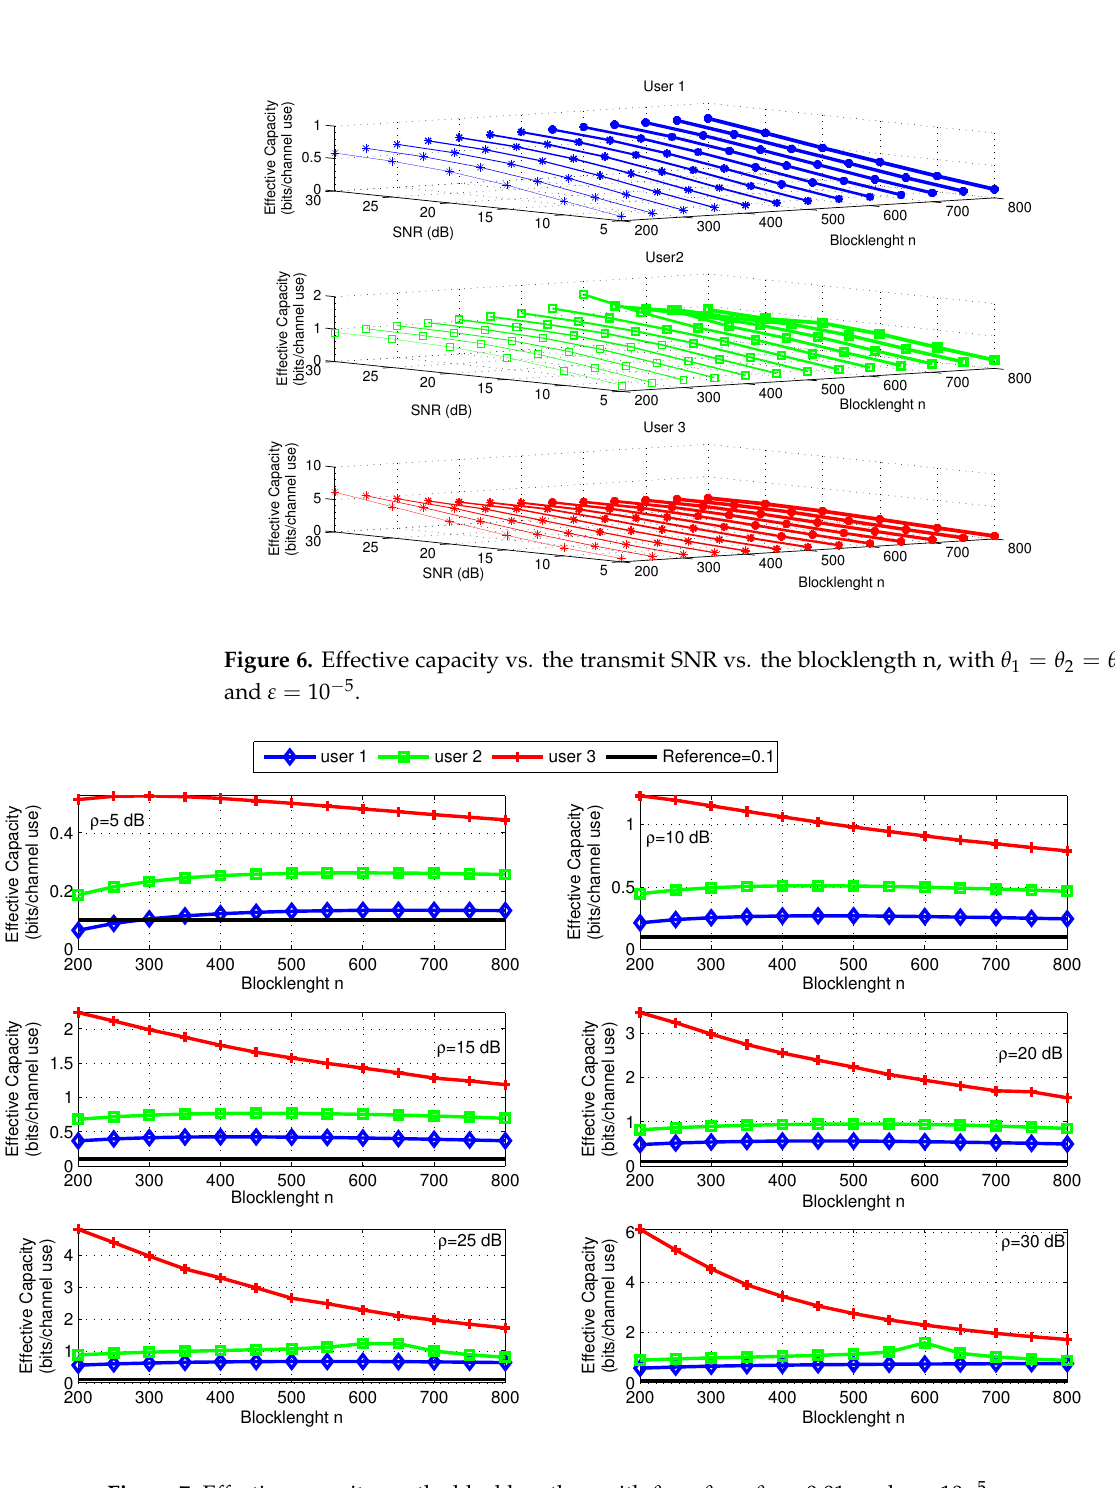
Figure 7. Effective capacity vs. the blocklength n, with θ 1 = θ 2 = θ 3 = 0.01, and ε = 10 − 5